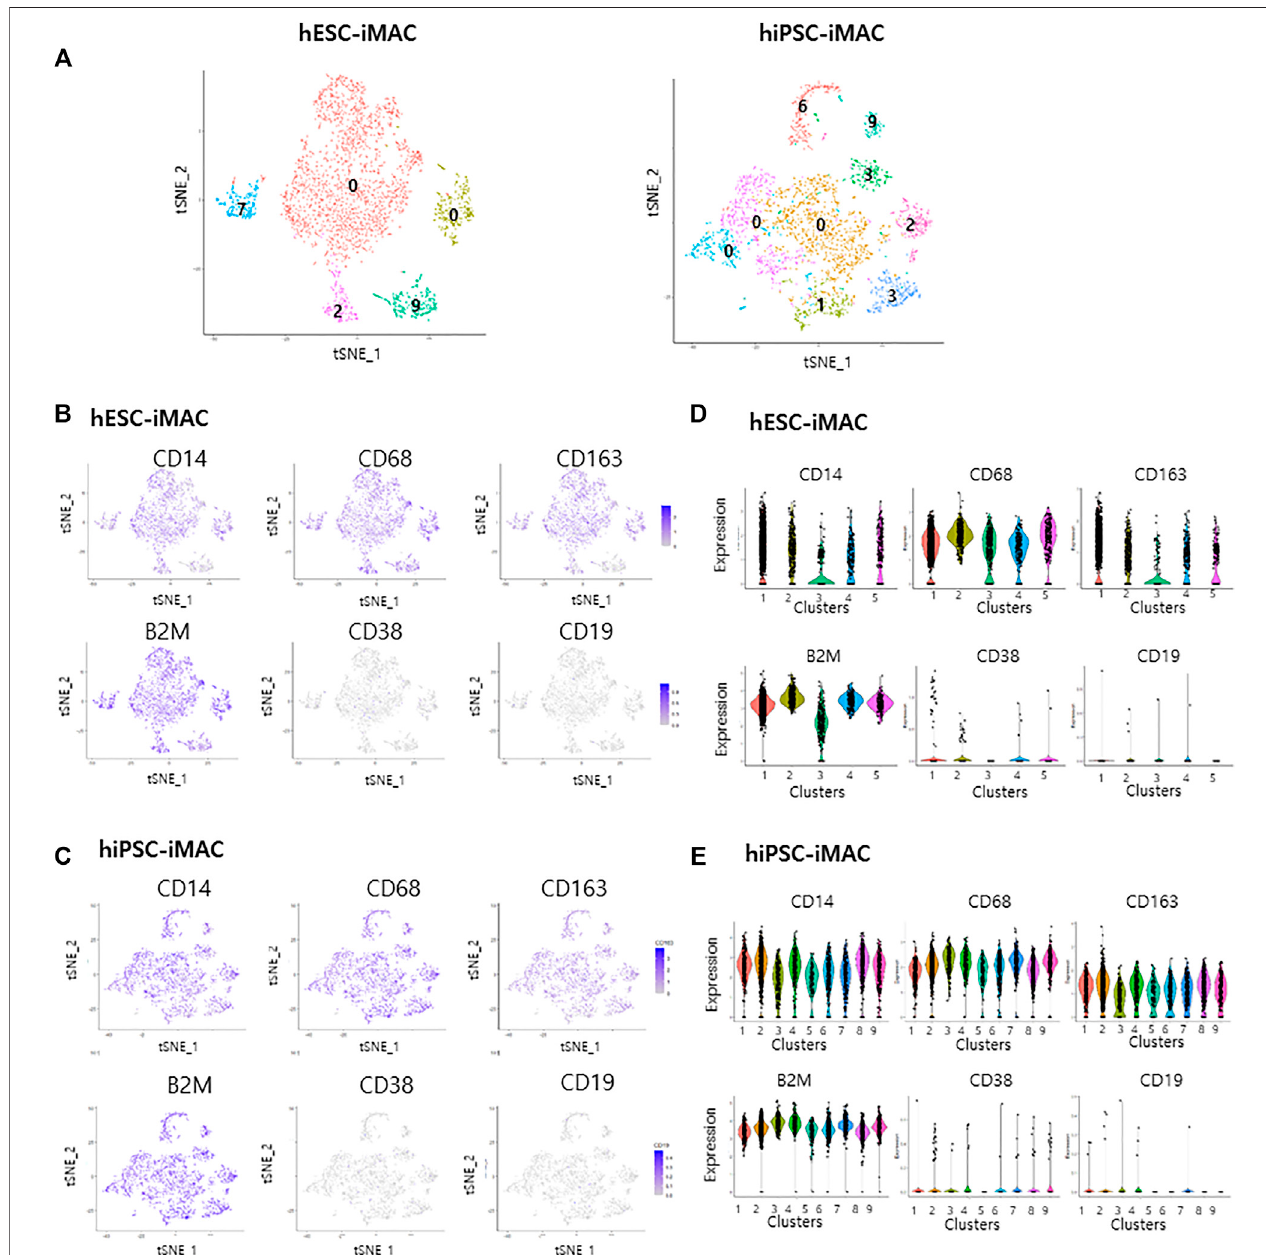
FIGURE5| Cellular homogenity withinthe fi lteredinducedmacrophages (iMACs) analyzed byILORegmethods. Intotal, 3,092hESCderivediMACs (hESC-iMAC) and3,138hiPSCderivediMAC(hiPSC-iMAC)wereanalyzed via two-dimensionaltSNEanalysistovisualizetheirsimilarity. (A) NumberofDEGsofeachcluster(Log2fold change > 1, p < 0.05, exclude mitochondrial genes) in hESC-iMAC (left) and hiPSC-iMAC (right). (B – E) The proportion of cells expressing macrophage-positive and macrophage-negativemarkergenesandthenumberofmappedgenes. (B,C) tSNEplotsand (D,E) violinandjitterplotsfortheexpressionofmacrophage-positive markers (CD14, CD68, CD163, and B2M) and macrophage-negative markers (CD38 and